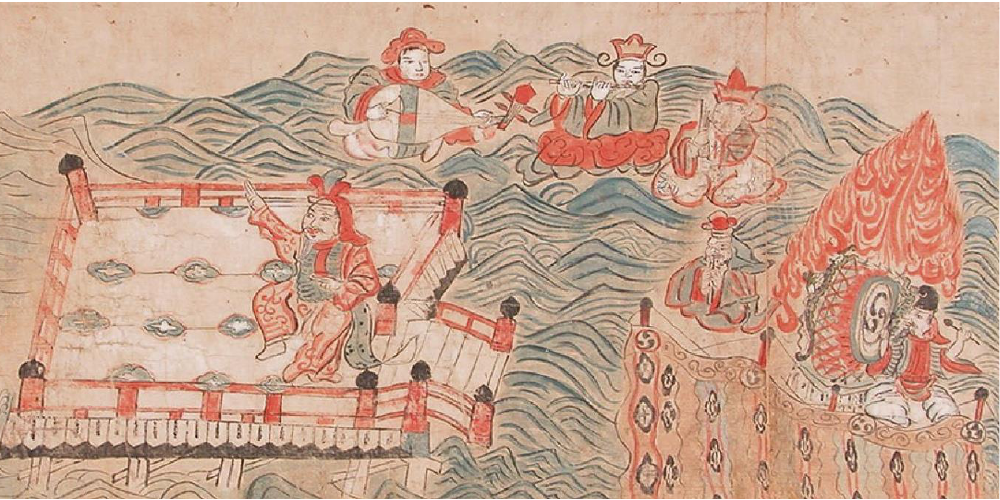
Figure 3. Hachimangū en gi 八幡宮縁起 (Story of Hachiman and his shrine, 1527). Hamaten Jingū Shrine. Currently at Umi-Mori Art Museum, Hatsukaichi, Hiroshima. Courtesy of the Hachiman Project, University of Heidelberg. At https://kjc-sv038.kjc.uni-heidelberg.de/hachiman/#O5172.8/,